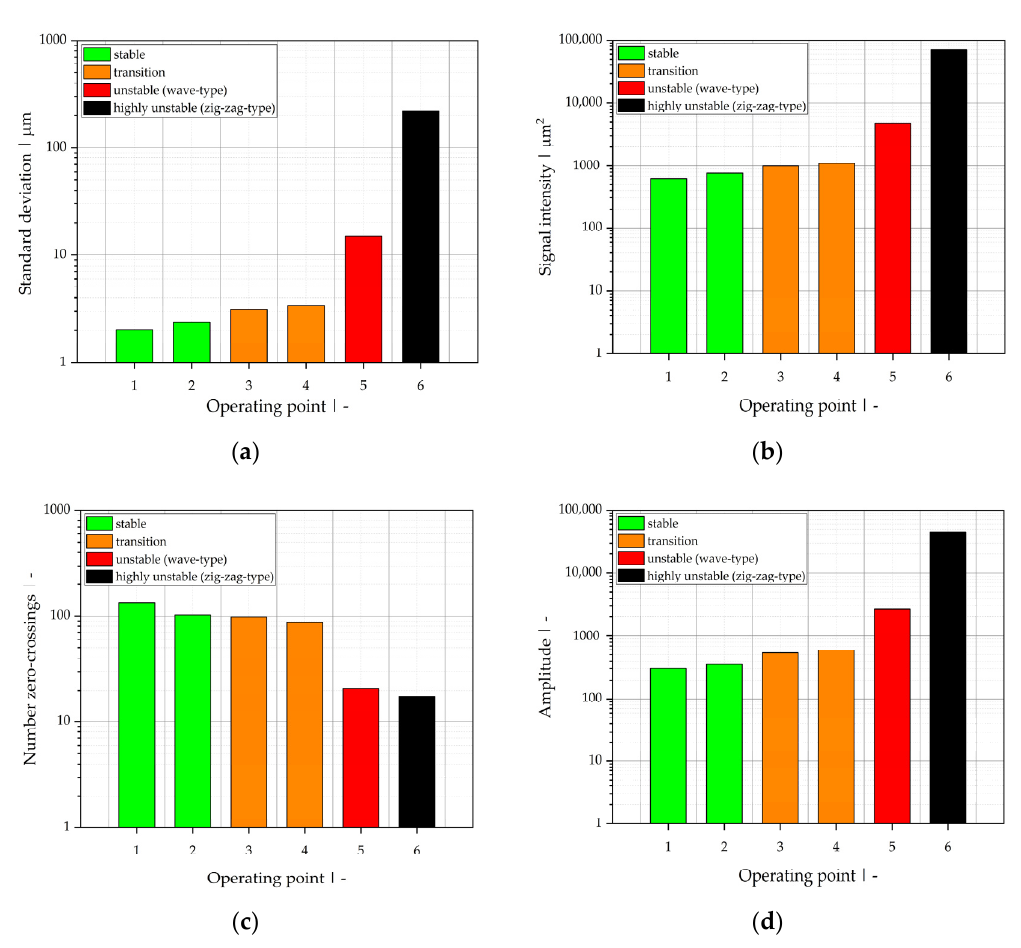
Figure 15. Quantitative values of ( a ) standard deviation, ( b ) signal intensity of measurement data, ( c ) number of zero- crossings, and ( d ) magnitude of the main frequency resulting from FFT for operating points 1–6. Process stability is indicated by the color of the bars: stable (green), transition (orange), unstable (red), and highly unstable (black). Table 9. Upper and lower limits of the parameters evaluated for stability classification.